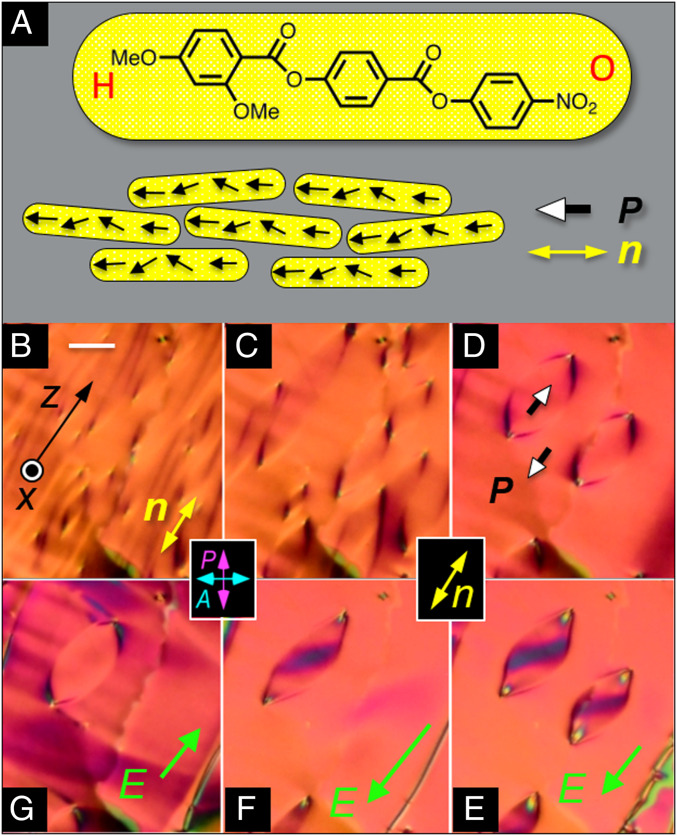
Ferroelectric nematic phase. (A) Structure of RM734 and schematic of molecular alignment in the ferroelectric nematic (NF) phase. The molecular organization is translationally symmetric in 3D and macroscopically uniaxial, with local mean molecular long axis, n(r), aligned generally along the buffing direction z, and polar, with a local, mean molecular dipole orientation, P(r), along n. H and O are used to represent the methoxy and nitro ends of the molecule, respectively. (B–G) DTLM images showing electro-optic evidence for ferroelectricity in a planar-aligned cell of RM734 in the NF phase (t = 11 µm thick). In the higher-temperature N phase, P(r) = 0, but when cooled into the NF phase without an applied field, RM734 spontaneously forms macroscopic domains with P > 0 or P < 0. When slowly cooled below the NF phase transition at T = 133 °C, the initial texture (B) coarsens into a pattern of domains with distinct boundaries (C). (D–G) T = 120 °C. Starting from D with no field, application of an ultrasmall in-plane test field |Ez| ∼0.5 V/cm along the buffing direction produces reversible reorientation of P without changing its magnitude. (E and F) Application of a negative Ez starts the in-plane reorientation of n(r) about x inside the domains, producing the dark bands there, while (G) positive Ez produces reorientation outside of the domains, proving that these regions are of opposite polarization. The E ∼ 1 V/cm threshold field for this reorientation indicates that n(r) in these domains is coupled to E by a polarization P ∼5 µC/cm2, which is comparable to the bulk polarization density measured electronically. The higher applied field in F has moved the boundary of one lenticular domain to increase the area with the field-preferred orientation, effecting a hysteretic reversal of P(r). (Scale bar, 30 µm.)